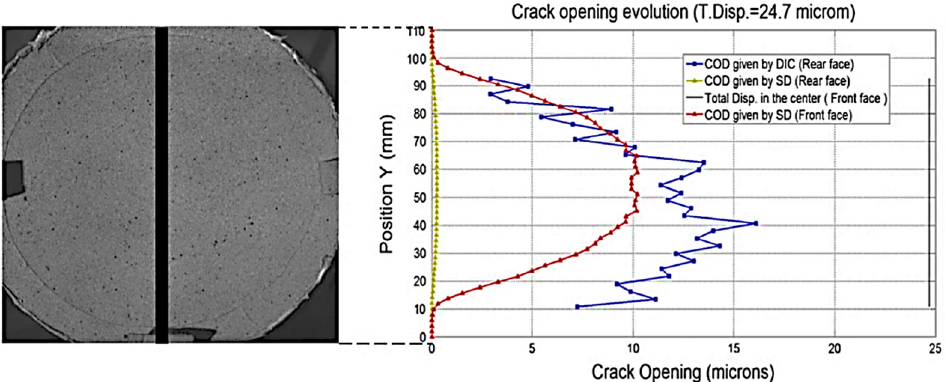
Figure 19. Pro fi le of the crack opening and path (Adapted with permission from reference [79]). Figure 19. Profile of the crack opening and path (Adapted with permission from reference